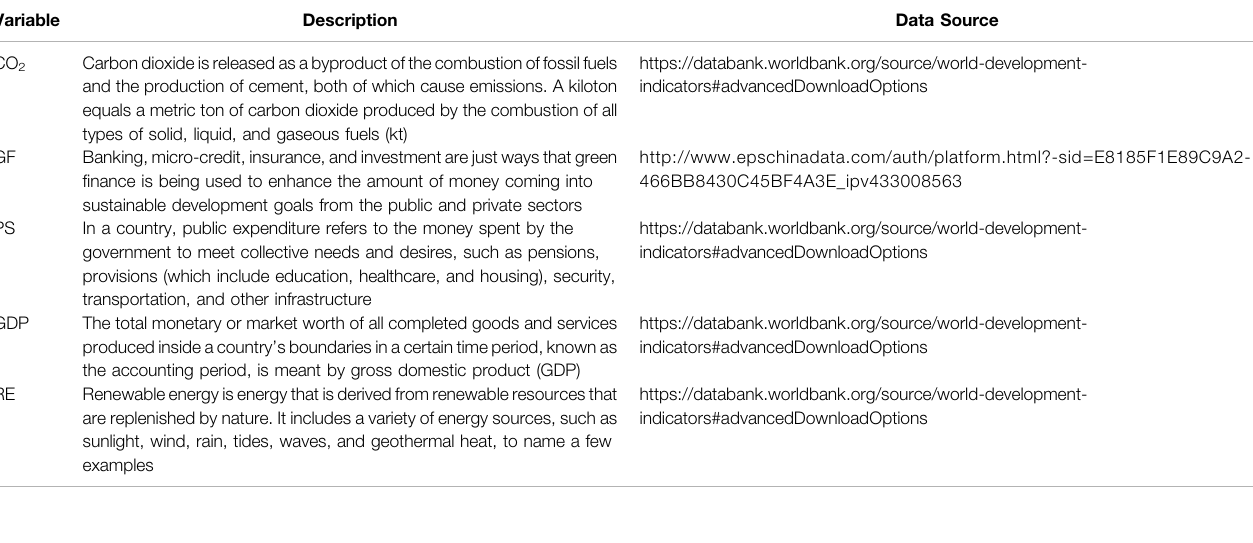
TABLE 1 | Variable description.